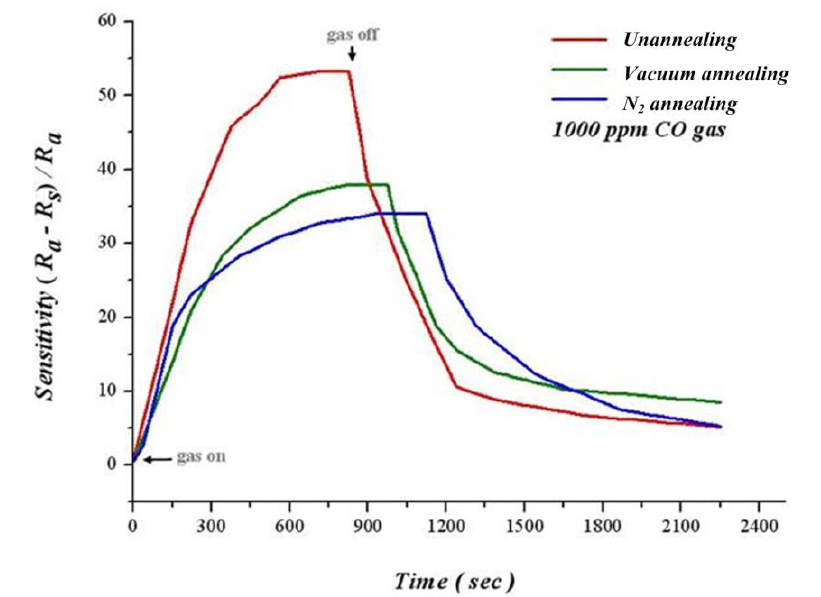
Figure 14. Analysis of different heat treatments to CO